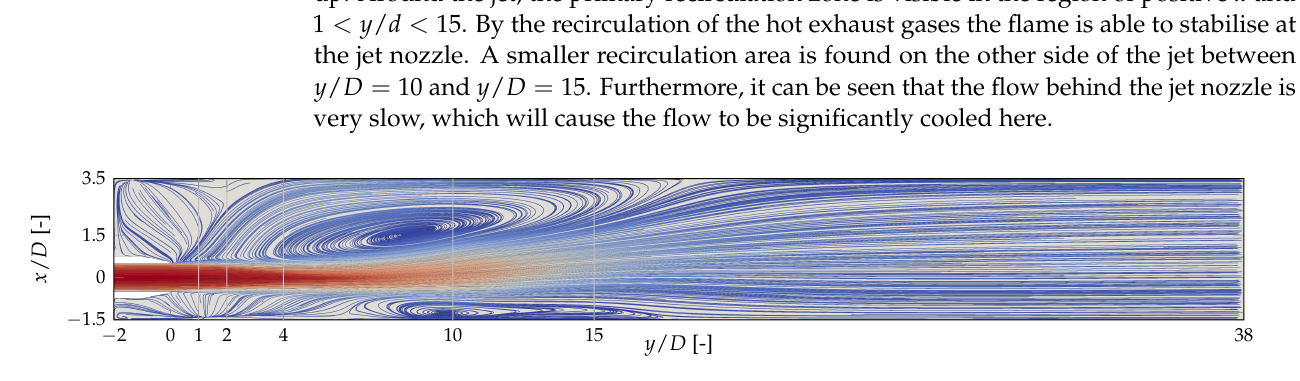
Figure 4. Streamlines along the symmetry surface coloured by velocity magnitude.